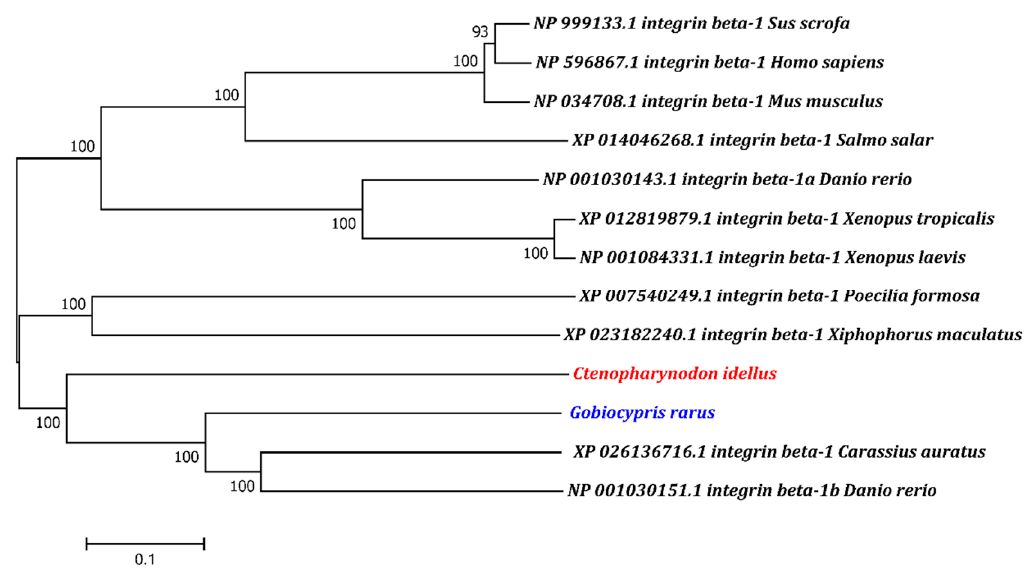
Figure 1. Phylogenetic relationship of the ITGB1 proteins in different species. A phylogenetic tree was constructed using the MEGA7 software. Ctenopharynodon idellus was highlighted in red and Gobiocypris rarus was in blue. Sus scrofa , Homo sapiens , and Mus musculus were introduced as outgroups.